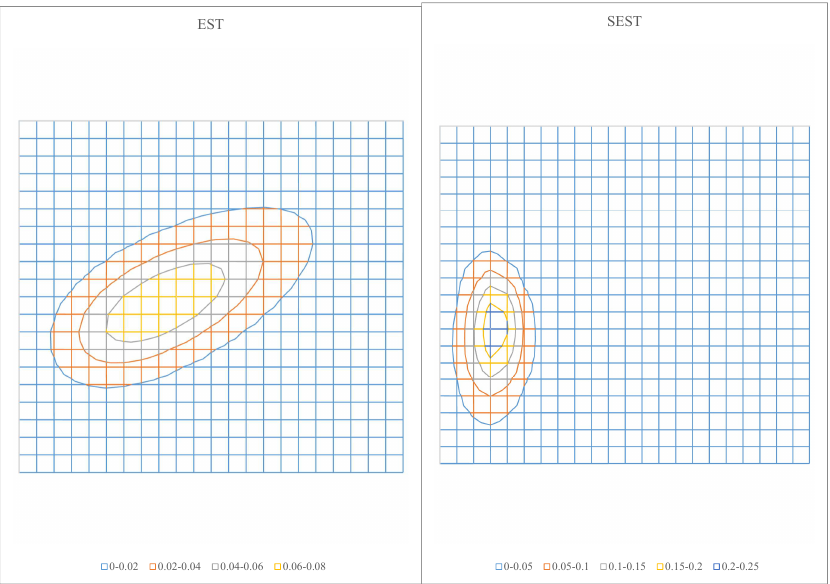
The figures show contour plots of the bivariate extended skew-Student [EST] and the standardized skew-Student [SEST].  = 5,  = 1,   = 2,   = 1. The X-Y axes scales are the same in all panels. Figure 10. Contour plots of the extended skew-normal and skew-Student density functions, ν = 5, 100, τ =